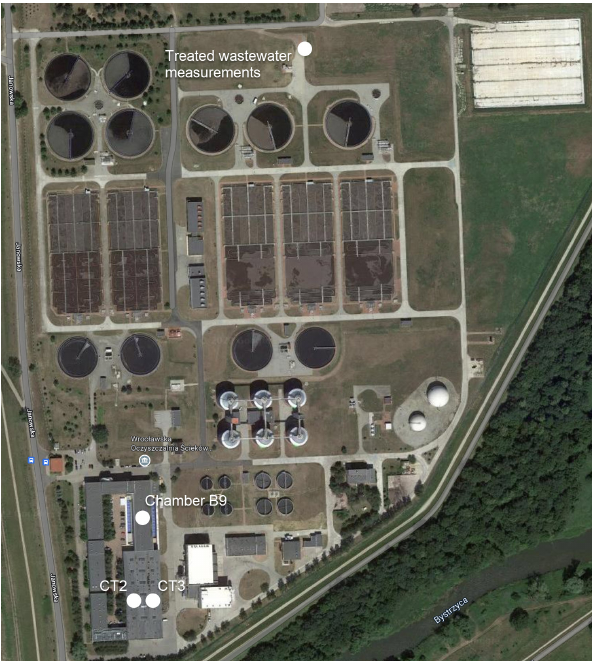
Figure 1. Locations of measurement sensors collecting operational